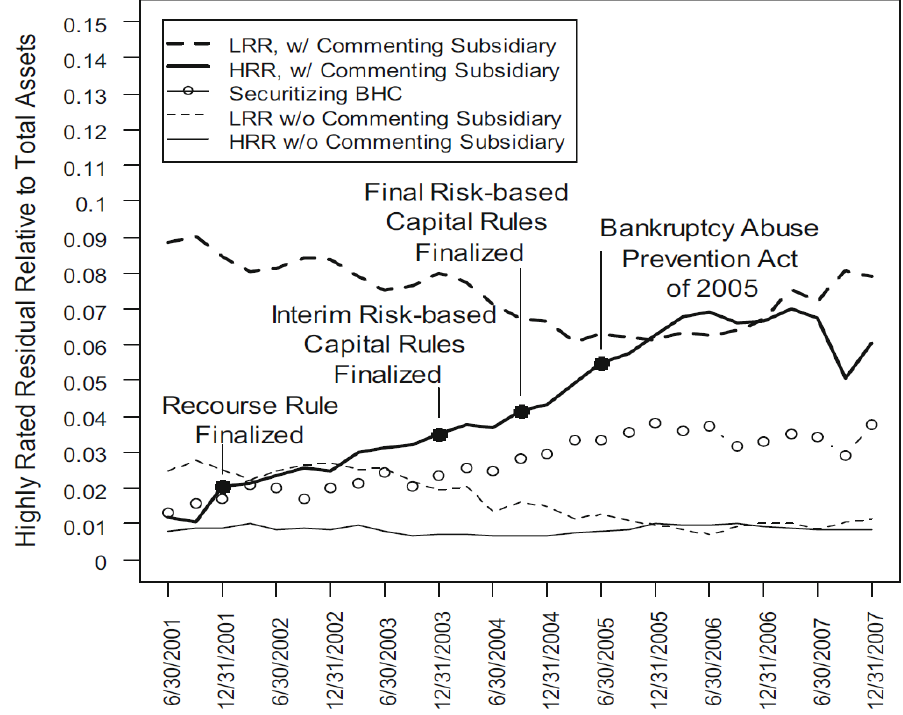
Figure 2. Estimated holdings of low-risk and high-risk CDOs at US banks. Source: Reproduced with permission from Miller (2018, p.